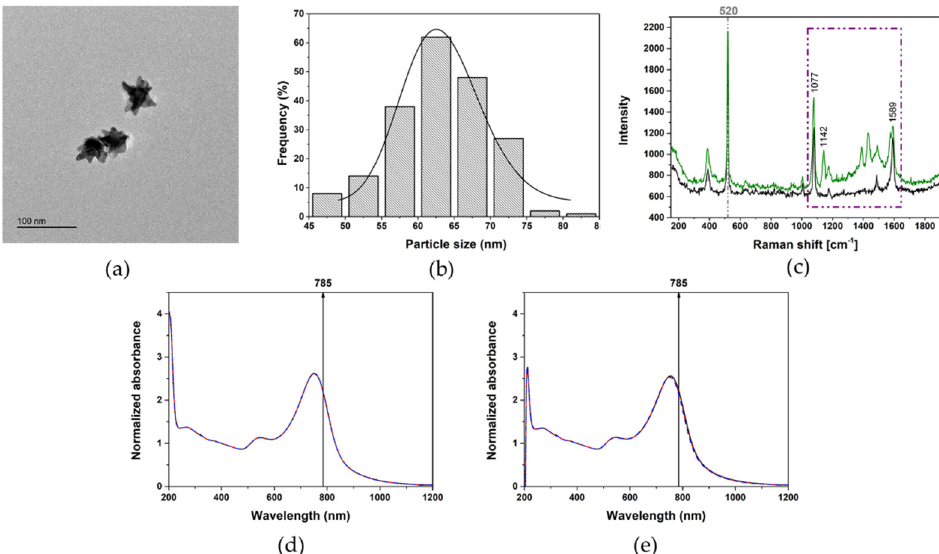
Figure 3. ( a ) TEM image of AuNSs and ( b ) relative particles size distribution and Gaussian fitting estimated on an average of 200 particles analysed. Scale bar of 100 nm. ( c ) Average SERS spectra of 4ABT-functionalised AuNSs (1 mM of AuNSs, black line) and sandwich-like configuration of AgNPs-4ABT-AuNSs (0.5 mM of AuNSs in the presence of 25 mg/L of PVP-Ag100nm NPs, green line). The characteristic peaks of 4ABT (purple dashed rectangle, C-H ring bending 1142 cm −1 and ring stretching 1077 and 1589 cm −1 ) are shown. The light-grey dashed line indicates the characteristic peak of silicon (520 cm −1 ) that was used as internal standard. AuNSs stability in ( d ) ultrapure water and ( e ) artificial seawater is shown. Times of 0, 15, and 30 min are represented by black, red, and blue lines, respectively. Black arrows show the wavelength excitation source at 785 nm used in SERS analysis.